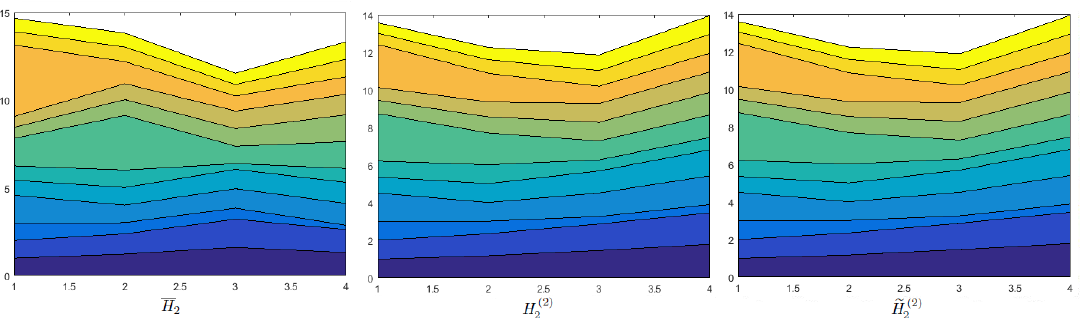
Figure 10. Area graphs of score values of H 3 .